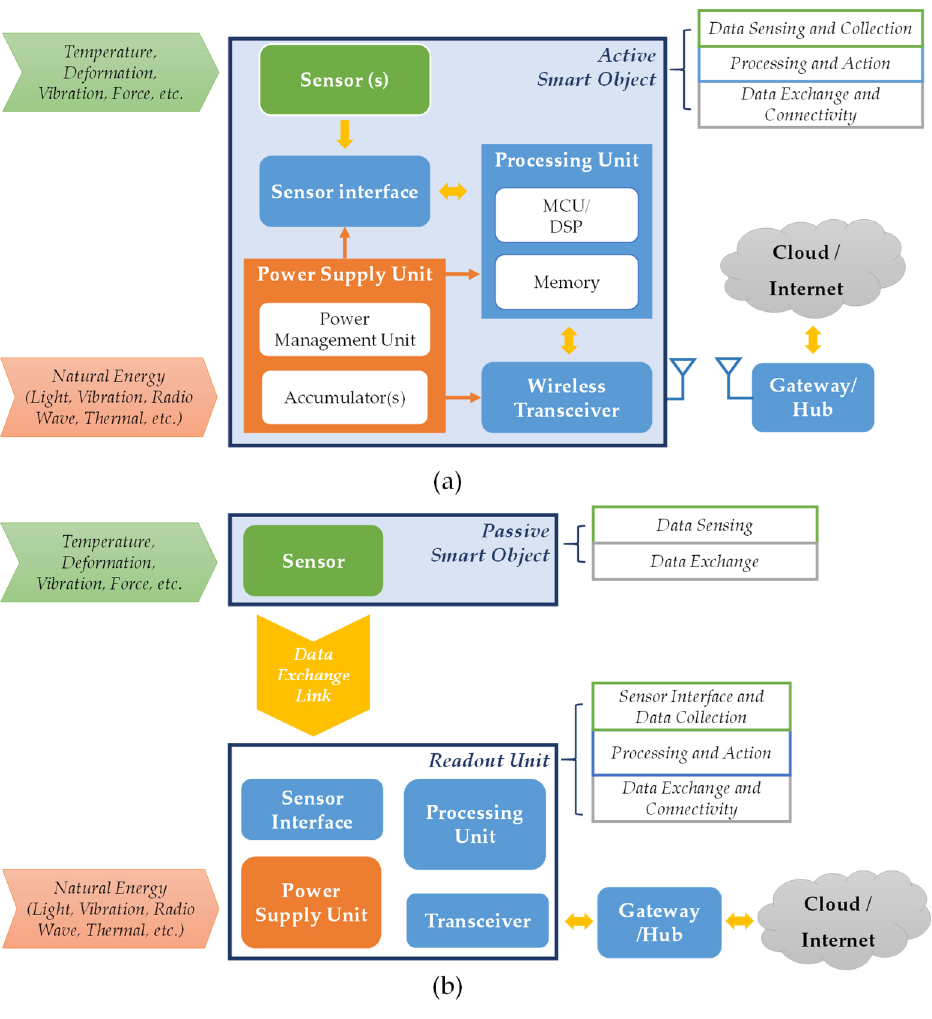
Figure 1. Architectures of ( a ) active and ( b ) passive smart objects. The smart object is equipped with sensors that detect changes in physical quantities like temperature, deformation, vibration, etc. In the case of active smart objects, electronics acquires, processes, and exchanges data with the network, while in the case of passive objects, an external readout unit acquires the sensor output wirelessly. The power supply unit can include (1) batteries, accumulator or systems that convert other natural energies into electrical energy and (2) a power management unit that controls and distributes the power supply (orange arrow) to the other blocks.